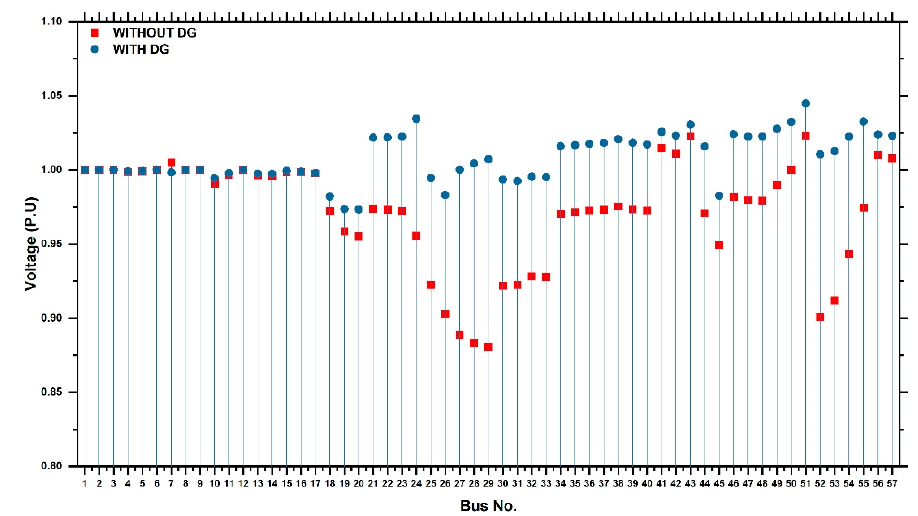
Figure 11. Load 2—voltage profile with and without a diesel generator.